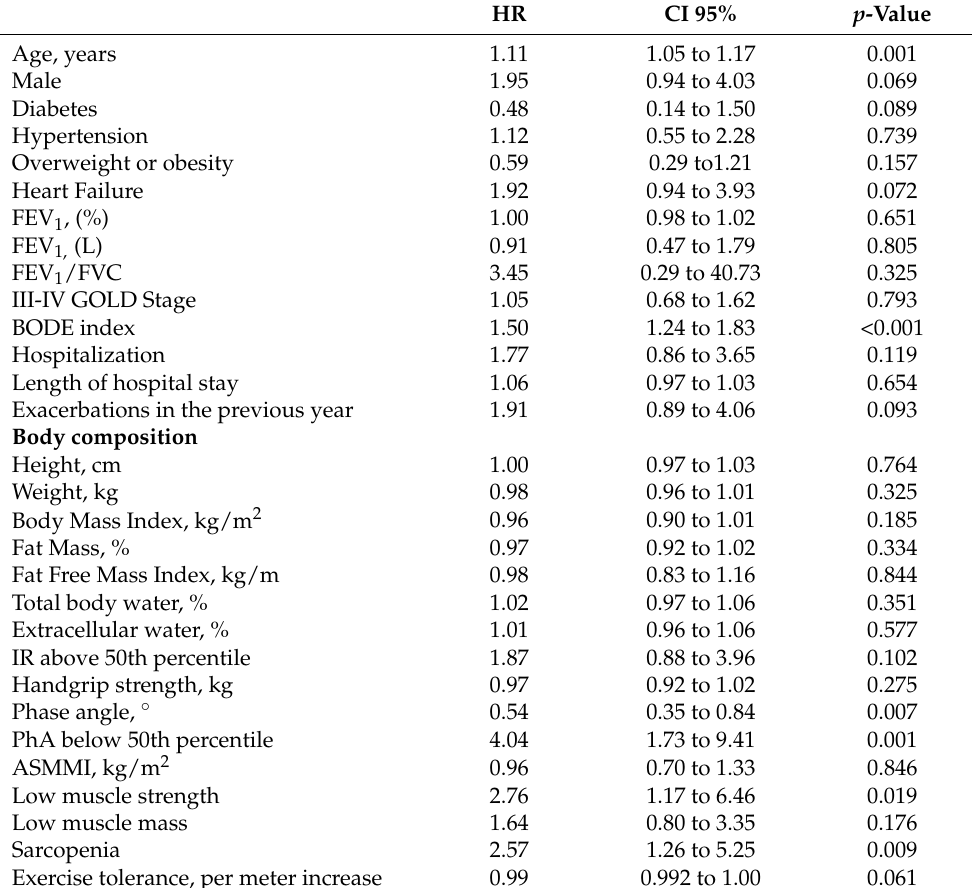
Table 2. Bivariate analysis of body composition predictors of mortality in COPD